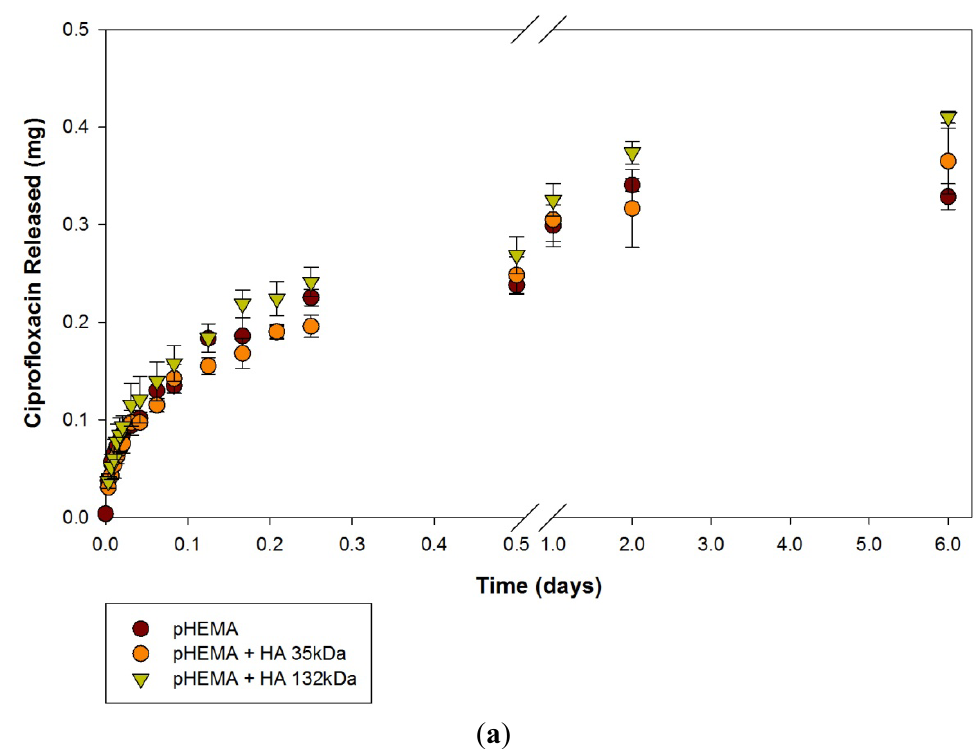
Figure 1. Ciprofloxacin Release curves from ( a ) pHEMA, ( b ) pHEMA TRIS and ( c ) DMAA TRIS materials. Values plotted are means ± SD. HA 35 kDa = 35 kDa Hyaluronic Acid. HA 132 kDa = Hyaluronic Acid 132